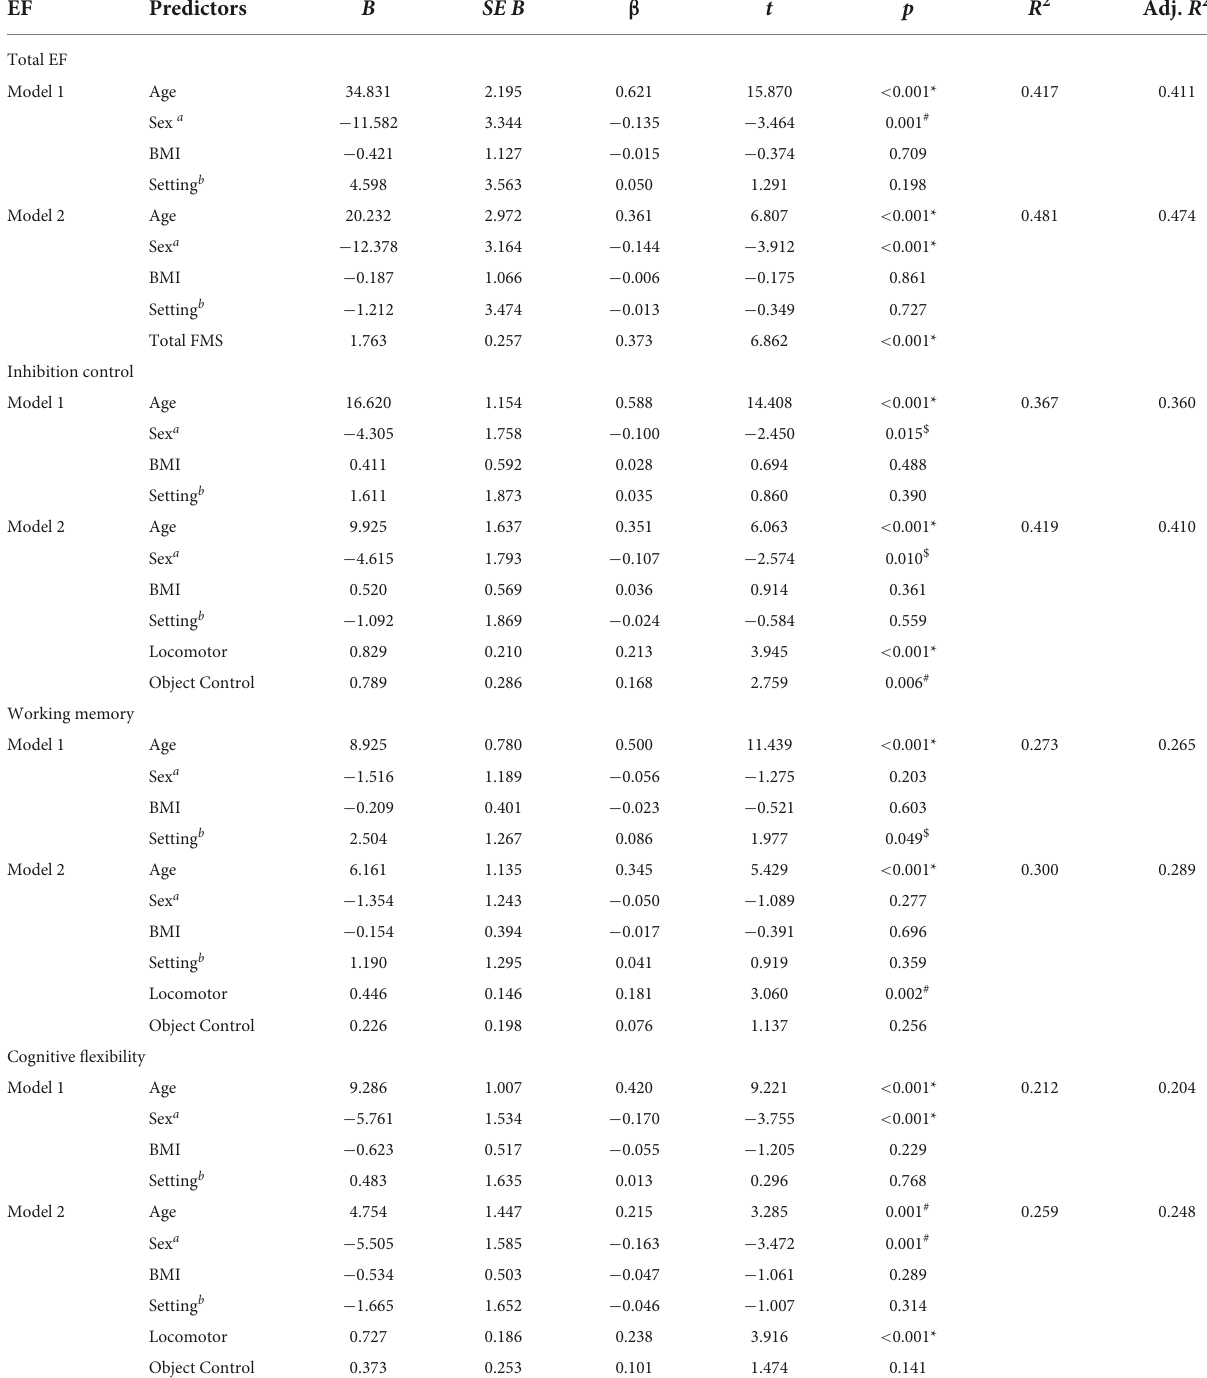
TABLE 3 The multiple linear regression analysis outcomes of FMS predicting performance on